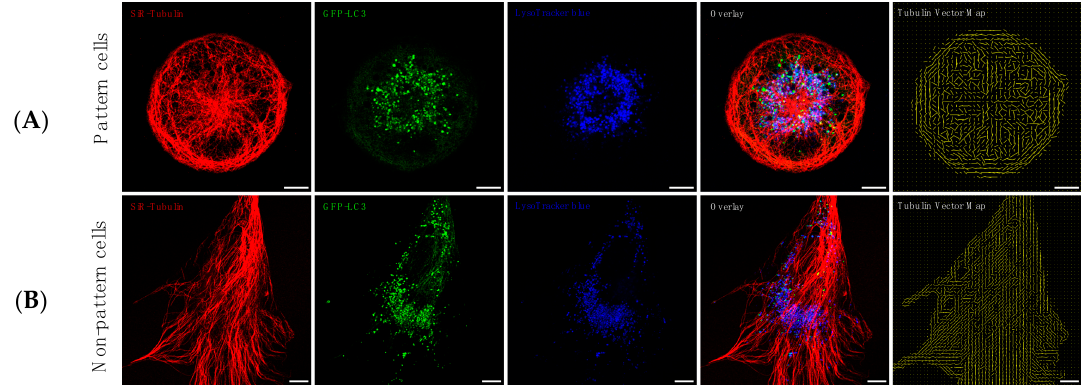
Figure 2. In order to enhance experimental control and to include geometry constraints, allowing to assess the contribution of tubulin organisation to autophagy pool size and vesicle dynamics, micropatterning was utilized. Micropatterned cells ( A ) display primarily perinuclear and branched organisation of autophagy pathway intermediates and a highly ordered tubulin network, while non-patterned cells ( B ) are characterized by a wide and asymmetric cytoplasmic distribution profile of autophagy pathway intermediates.